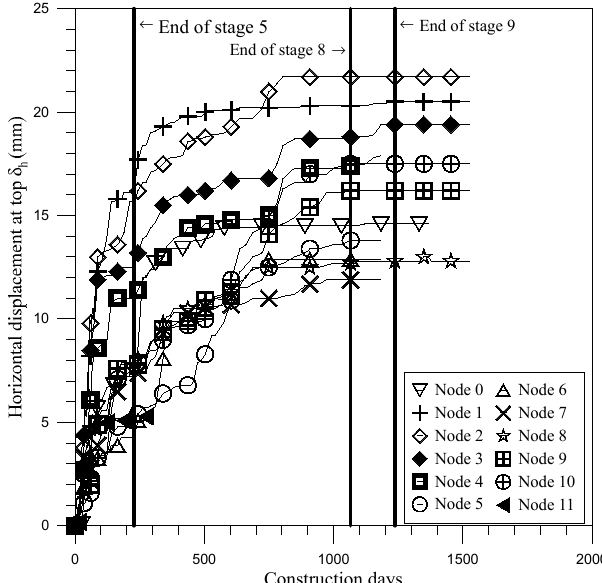
Figure 13. Deflection of points 0–11.